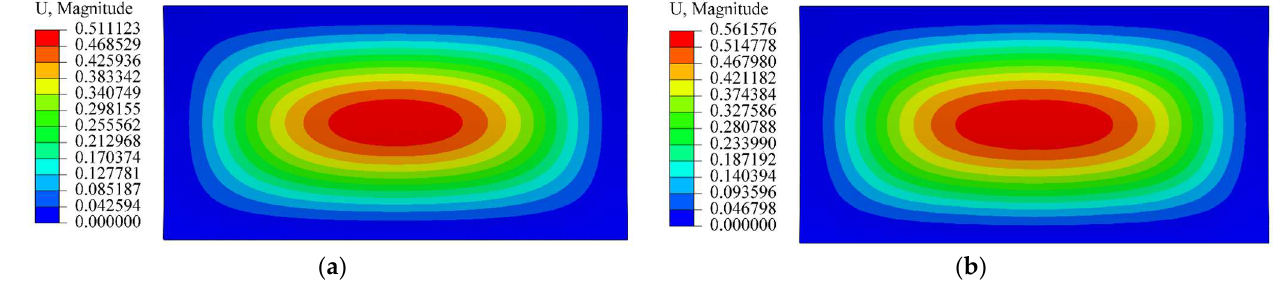
Figure 10. Displacement nephogram when Ra 2 / t = 3/2 and q = 30 Kpa. ( a ) E + / E − = 1; ( b ) E + / E − = 2.